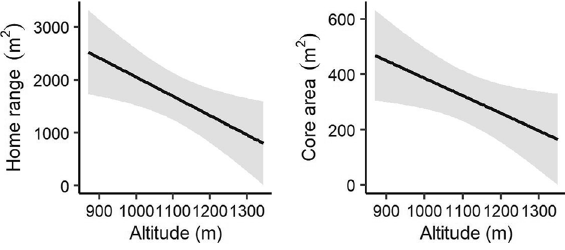
Figure 2. Topographic effects on the home range and core area of red-backed voles ( Myodes regulus ) determined by the linear